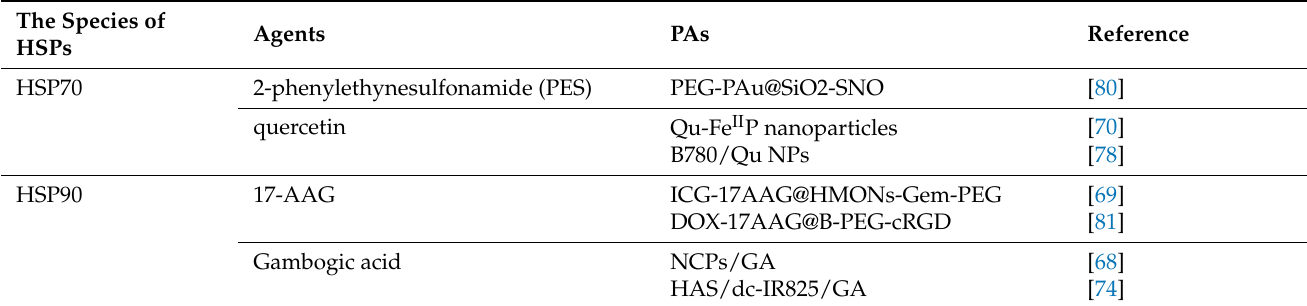
Table 1. HSP inhibitors for